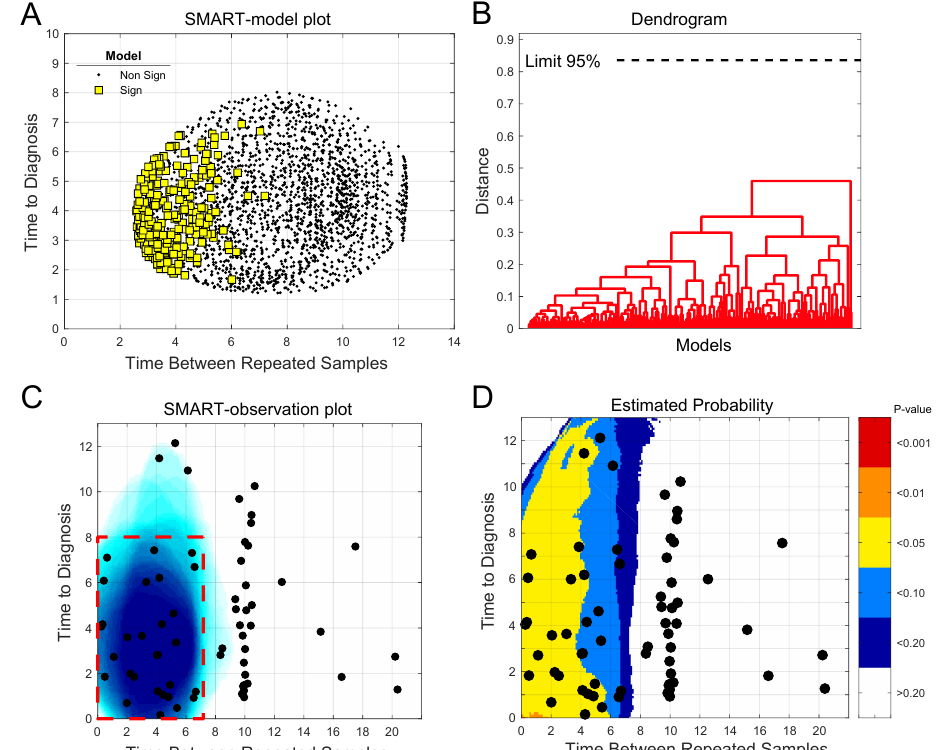
Figure 2. Use of the SMART procedure to find regions of interest for metabolic marker pattern detection for glioma. Subsets were selected by scanning time to diagnosis and time between repeated samples in steps of 0.25 years. In total, 2170 unique subsets, each consisting of twenty case-control observations, were created. ( A ) SMART-model plot showing mean time to diagnosis and time between repeated samples for the 2170 OPLS-EP models, out of which 277 models were statistically significant, P < 0.05 (yellow squares). ( B ) Dendrogram showing similarities between significant OPLS-EP models. All significant models had a similar underlying metabolic pattern, detected as one cluster. ( C ) SMART- observation plot for all glioma case-control observations showing the distribution pattern of subsets with significant OPLS-EP models (blue). Significant subsets were mainly composed of case-control observations collected less than eight years prior to diagnosis and with less than seven years between baseline and repeated samples, which defines the region of interest for detection of a glioma-related metabolic marker pattern (red dashed line square). ( D ) Estimated probability plot in comparison to simulated random data. The plot shows the probability ( P -value) of obtaining the distribution pattern shown in ( C ) as a random event. Areas are color coded according to p -values < 0.001 to < 0.2, indicating the risk of a false positive